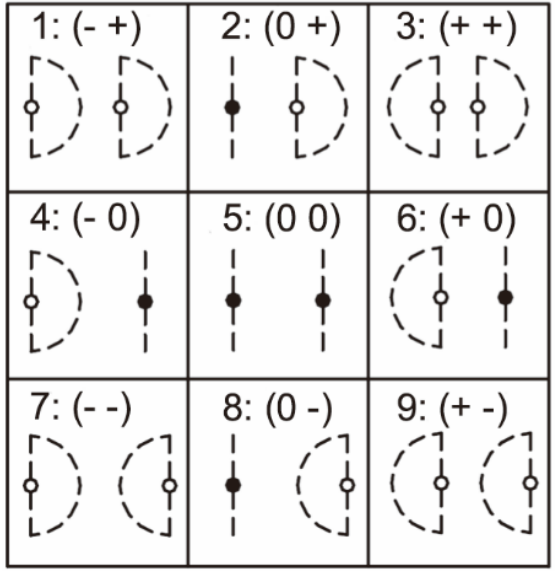
Figure 1. Icons for QTC B in 2D